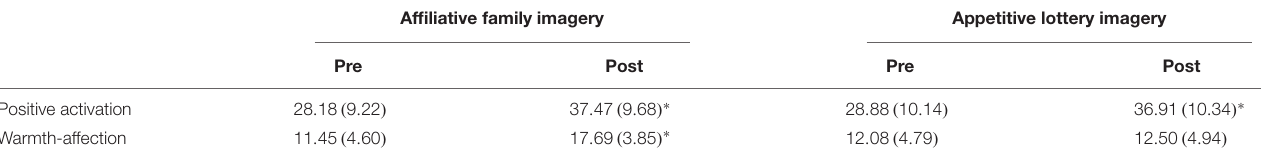
TABLE 2 | Means (SD) of affect scores pre and post the family and lottery